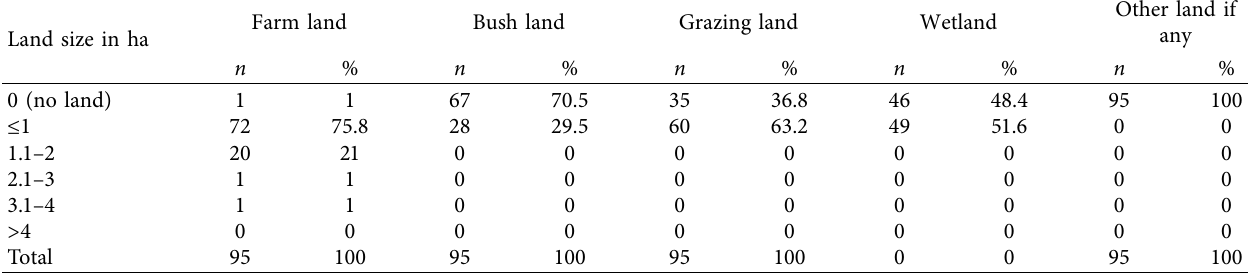
Table 5: Landholding size of the households across their land use types.